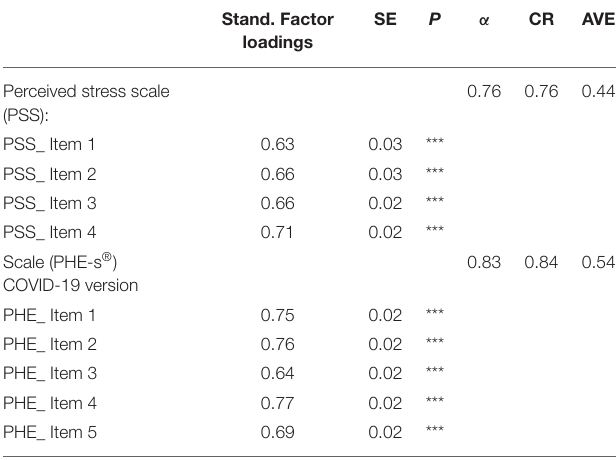
TABLE 3 | Confirmatory factor analysis